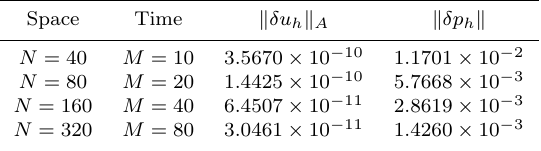
Table 1. Errors in energy norm for displacements and L 2 -norm for pressure at time T = 0 . 1 by using the perturbed finite-difference scheme (2.17).